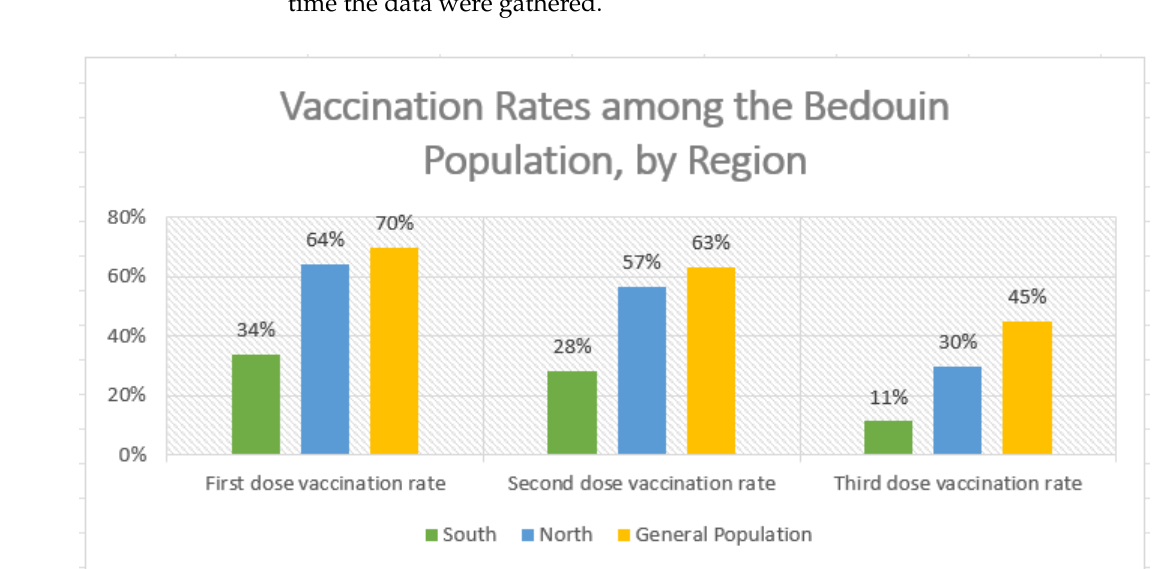
Figure 3. Vaccination rates among the Bedouin population, by region. Table 1. Two-Sample t-test results, assuming equal variances.